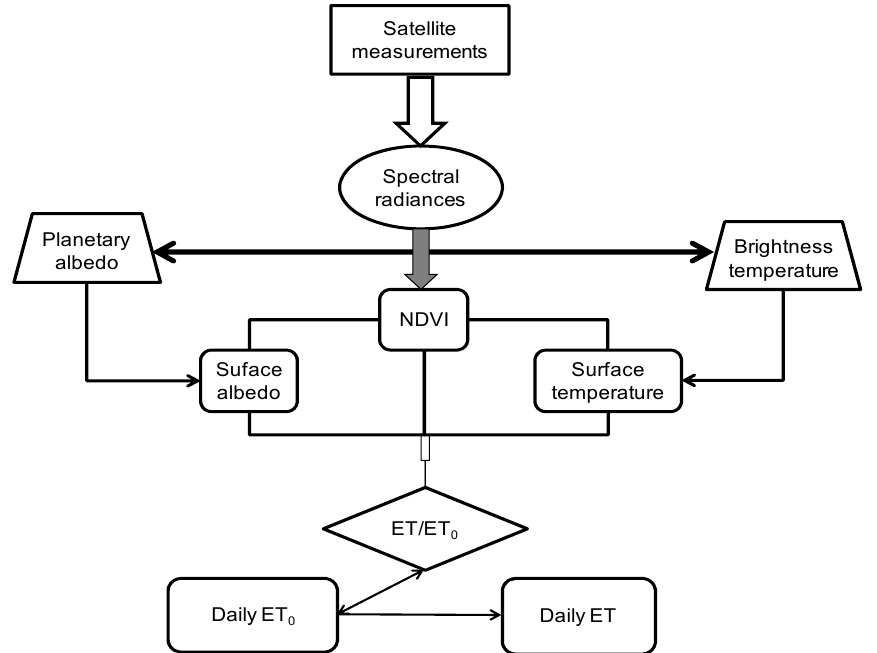
Figure 2. Schematic flowchart for calculating the actual evapotranspiration when applying the PM2